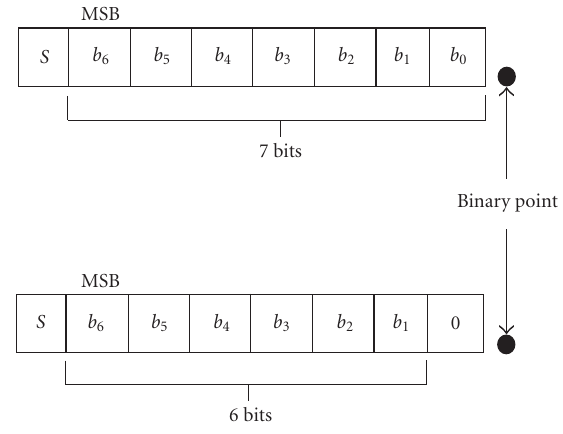
Figure 7: A datapath wordlength of (a) seven bits and (b) the data- path wordlength truncated to six